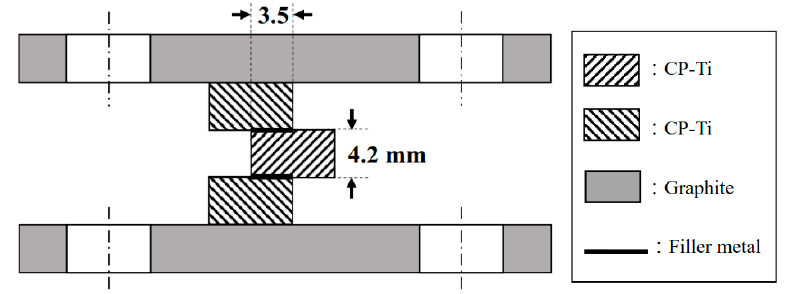
Figure 1. Schematic diagram of the shear test specimen [18].